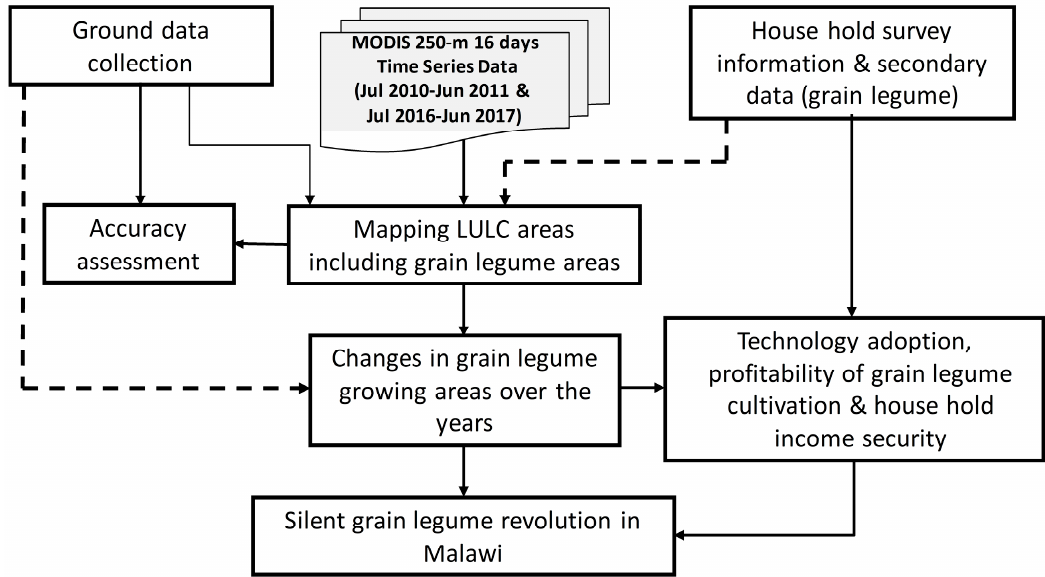
Figure 3. An overview of the methodology used for mapping LULC areas using MODIS data.